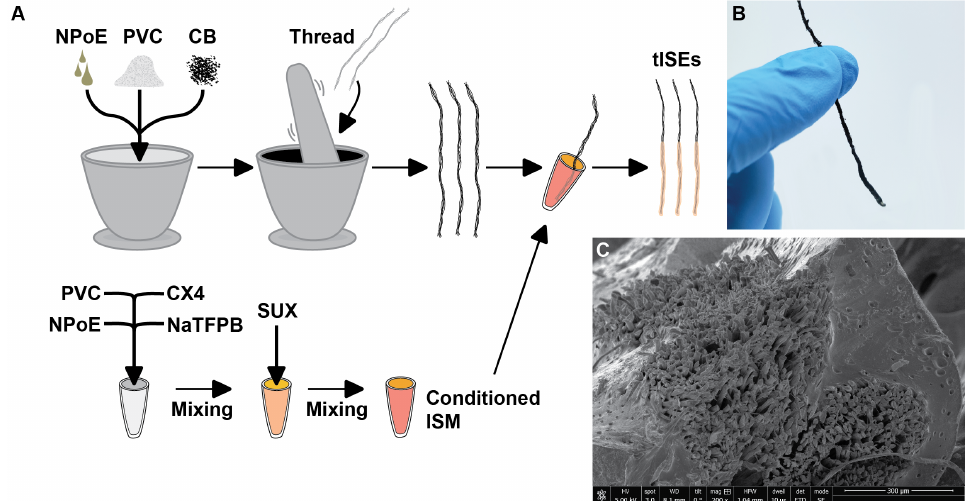
Figure 2. ( A ) The fabrication of the thread-based ISEs. The polymer support (PVC), plasticizer (NPoE), and carbon black (CB) were mixed using a mortar and pestle and deposited onto thread to make the thread-based conductive electrodes. The electrode was then dipped into the sensing cocktail to form the SUX-sensing membrane on the electrodes. ( B ) shows a fully-fabricated thread-based ISE, and ( C ) shows the SEM image of the cross-section of thread-based ISE. The smooth membrane coats the microscopic